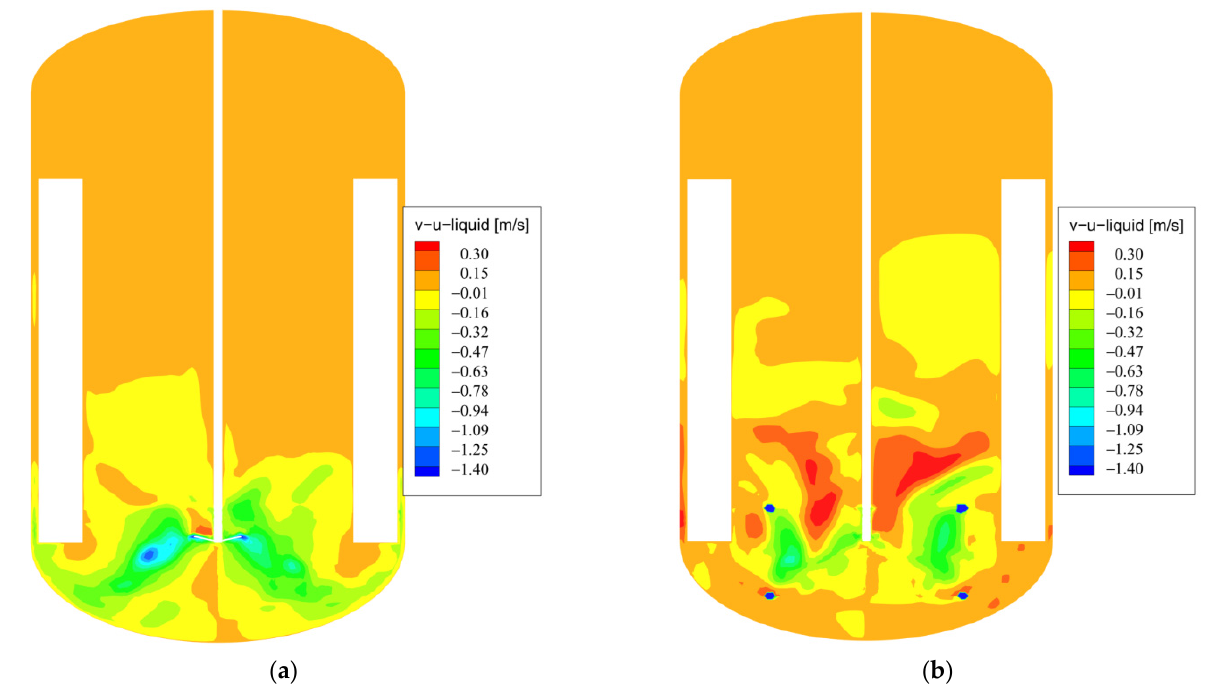
Figure 9. Tangential velocity distribution of the liquid phase: ( a ) flow started from the solid phase fully sedimented; ( b ) flow started from the solid phase dispersed in the entire volume of liquid.